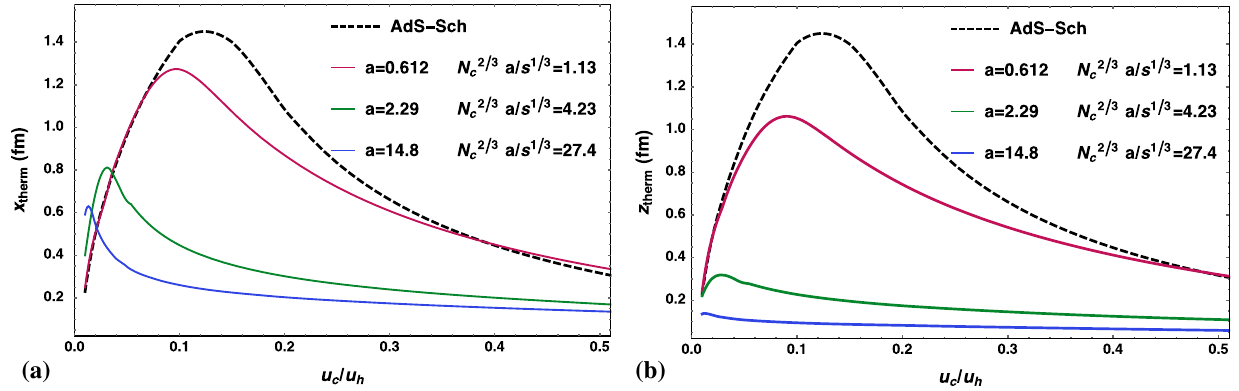
Fig. 6 The maximum stopping distance of the jet moving a in the x- direction and b in the z-direction in the anisotropic background with different anisotropy parameters. The anisotropic plasma has the same entropy density as the isotropic plasma, N − 2 c s = 0 . 159 GeV 3 . In all